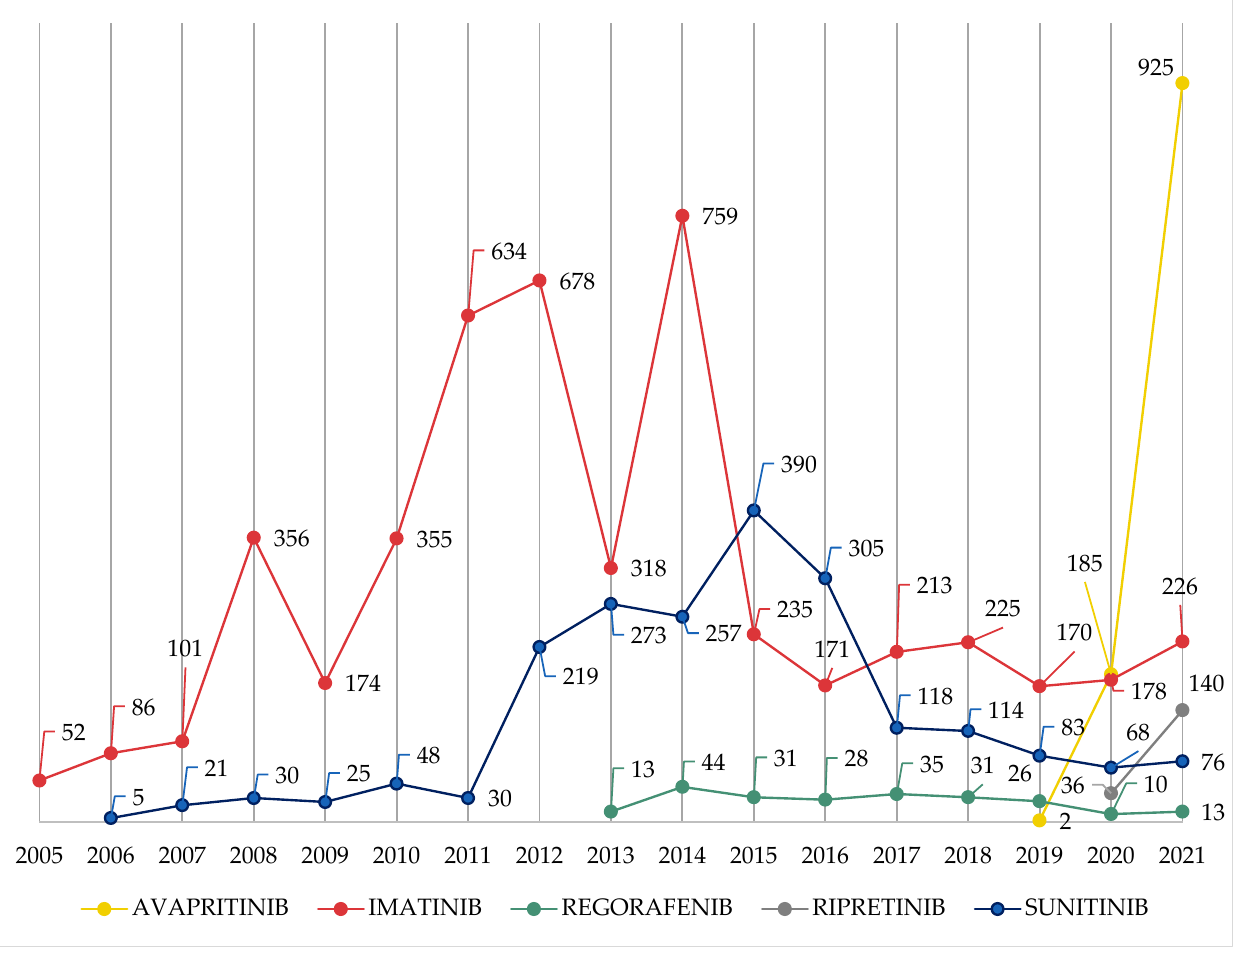
Figure 2 . Trend over the years of TKI-related ICSRs with a GIST indication reported in EV database. Abbreviations: EV = EudraVigilance; GIST = gastrointestinal stromal tumor; ICSR = individual case safety report; TKI = tyrosine kinase inhibitors. Table 1. Characteristics of TKI-related ICSRs approved for GIST collected into